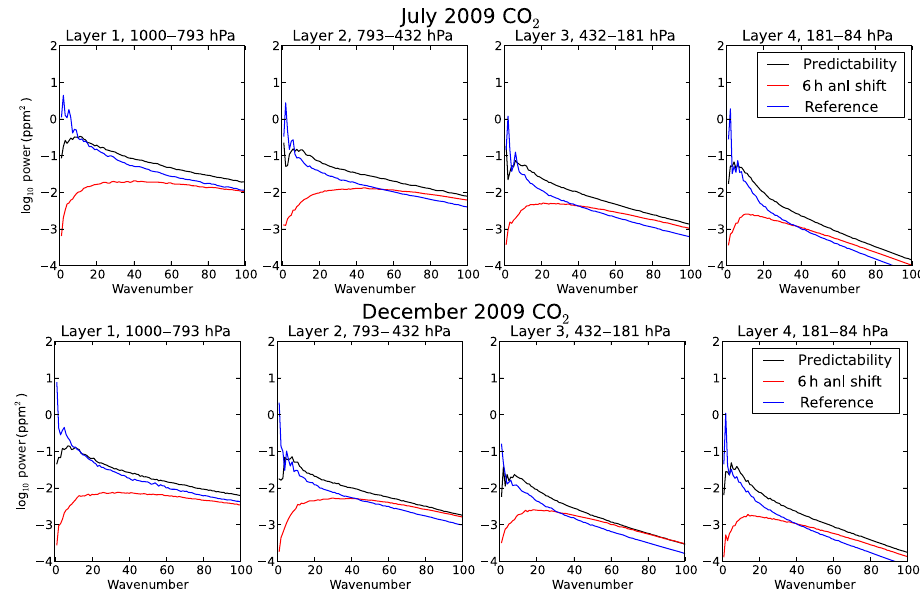
Figure 11. Spectra of various fields as a function of total wavenumber. Spectra are averaged over 1 month for July 2009 (top row) and December 2009 (bottom row) and over 12 model levels. The lower and upper model levels averaged are indicated above each frame. Ap- proximate pressure is obtained from model level by multiplying by 1000 (which corresponds to assuming a reference surface pressure of 1000hPa). The CO 2 reference state spectra (blue curves), predictability error (black curves) and error due to a 6h shift in analysis fields (red curves) are